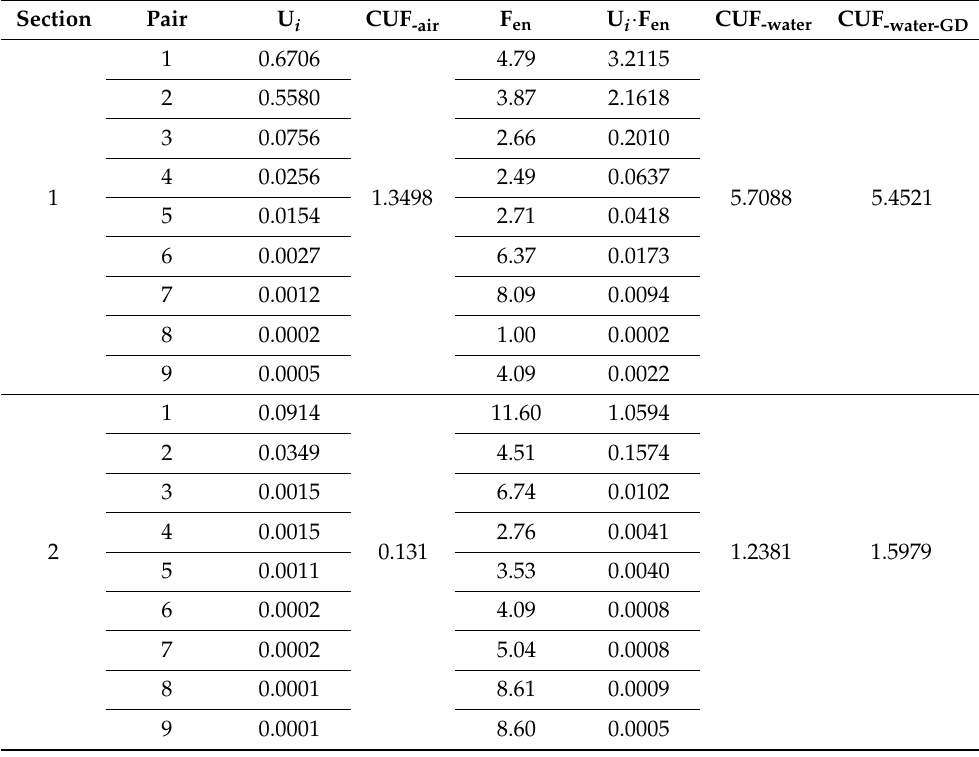
Table 3. Environmental fatigue calculation result of sample problem 2.